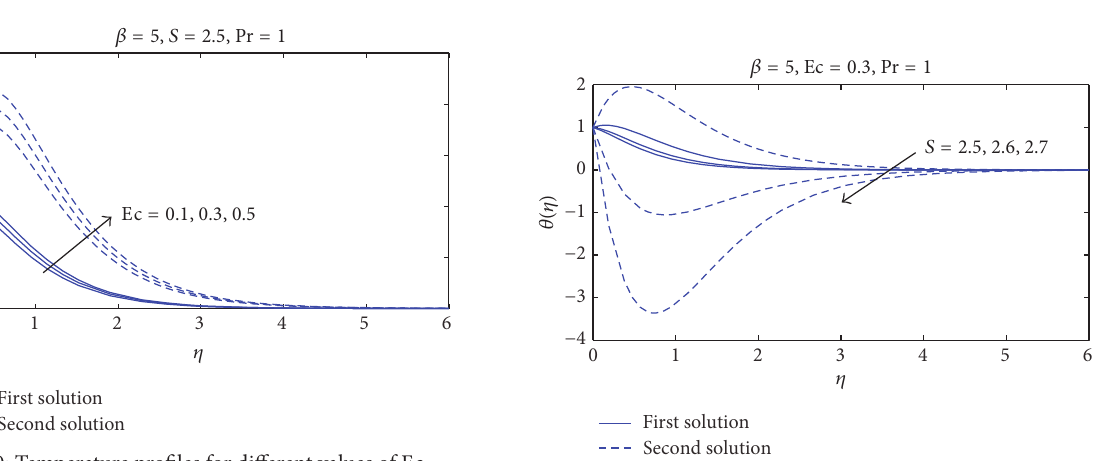
Figure 13: Temperature profiles for different values of 𝑆